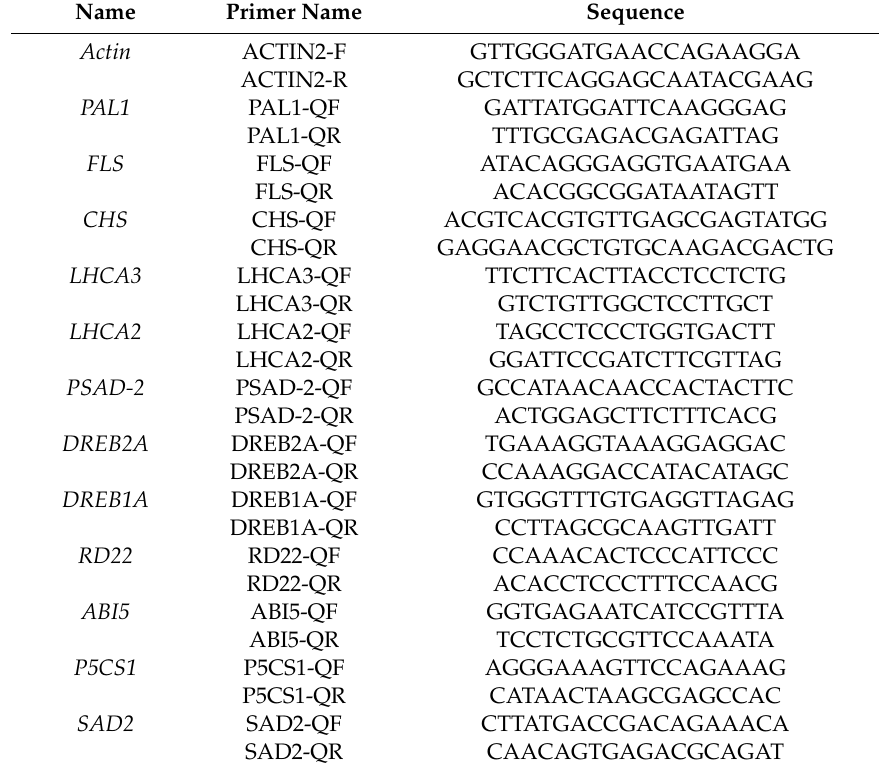
Table 7. The primers of